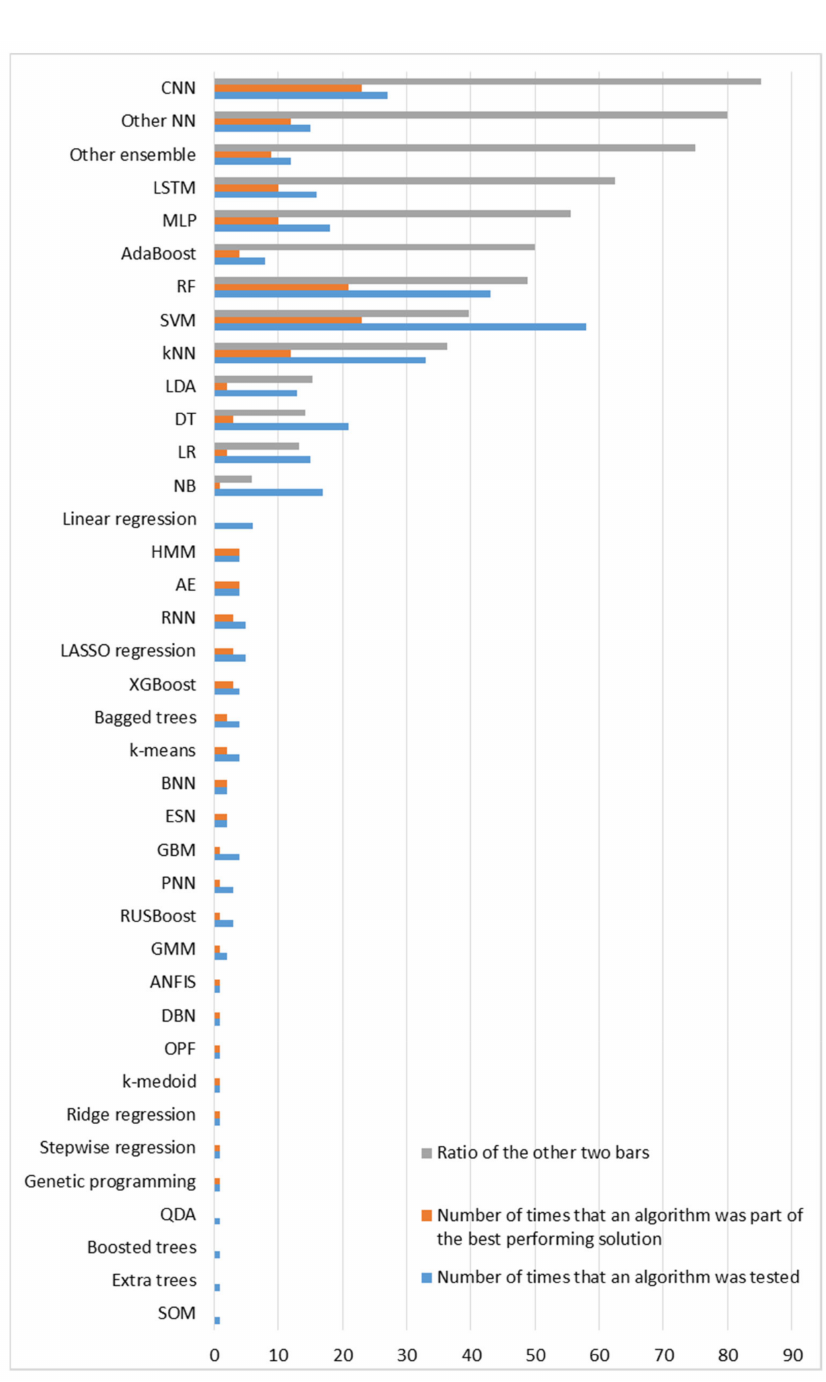
Figure 11. Distribution of the deployed ML algorithms over the considered studies. The blue bar depicts how many times each algorithm was tested, while the orange bar depicts how many times the same algorithm was selected as the best performing model or as a part of the final proposed solution. For the most widely tested algorithms, the ratio of the two previous values (grey bar) is also depicted